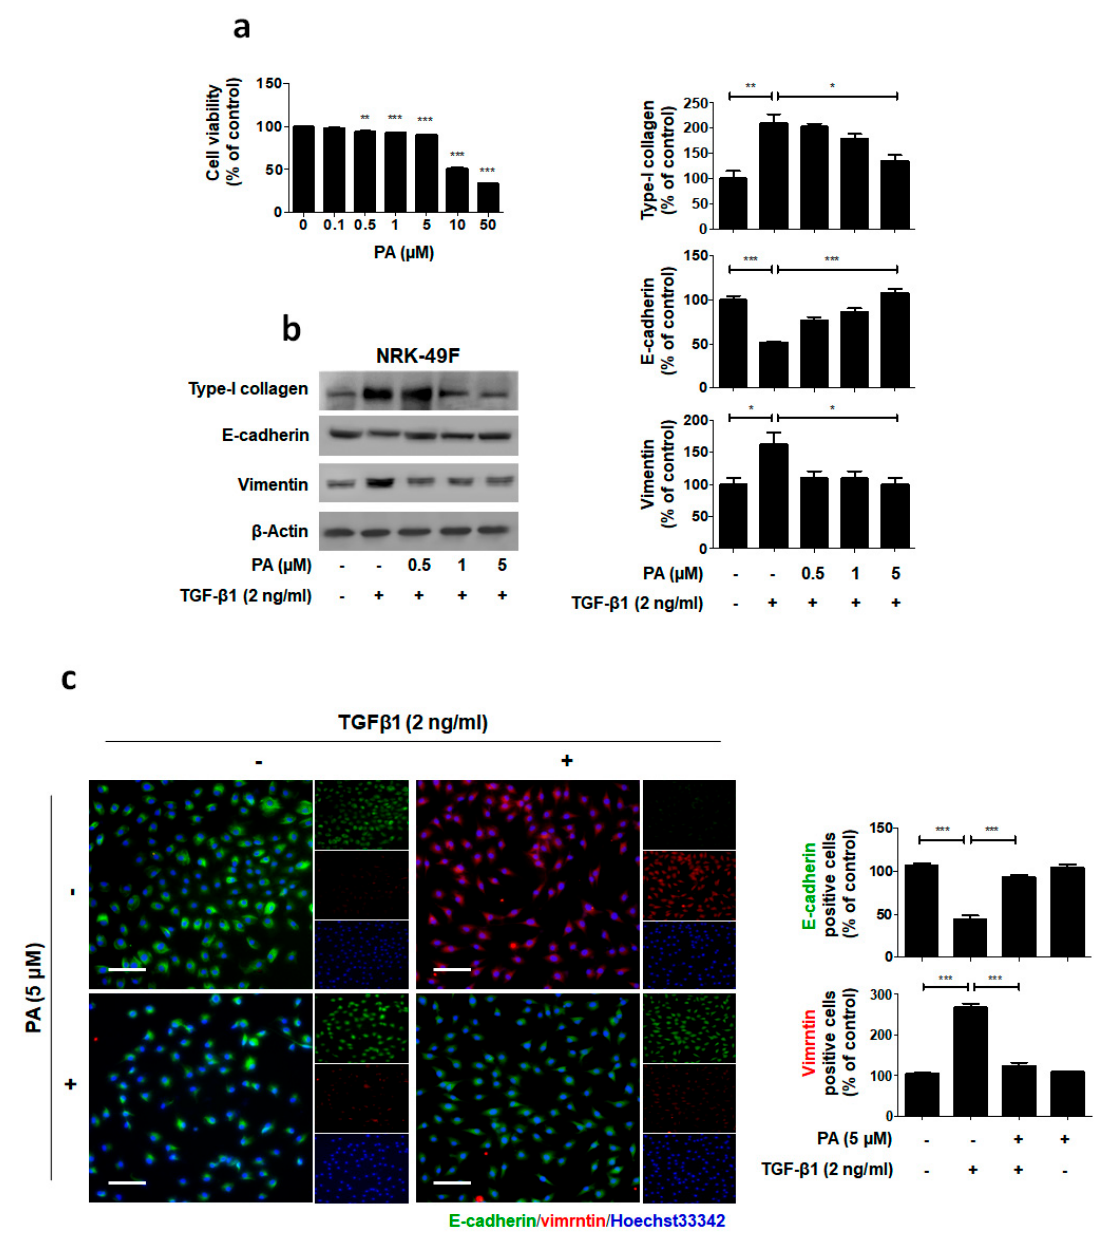
Figure 4. Suppression of TGF- β 1-induced ECM and EMT by PA. ( a ) Cells were treated with PA for 24 h, and then MTT assays were conducted. ( b ) Immunoblot results show the effect of PA on the inhibition of TGF- β 1-induced type-I collagen expression and changes in EMT markers, including E-cadherin and vimentin. β -Actin was used to confirm equal sample loading. ( c ) Immunofluorescence double staining for E-cadherin (green) and vimentin (red) localization. Cells were counterstained with Hoechst 33342 (blue). Scale bar 50 µ m. The data are representative of three independent experiments and quantified as mean values ± SEM. Tukey’s multiple comparison test, * p < 0.05, ** p < 0.01, *** p < 0.001 compared to control.